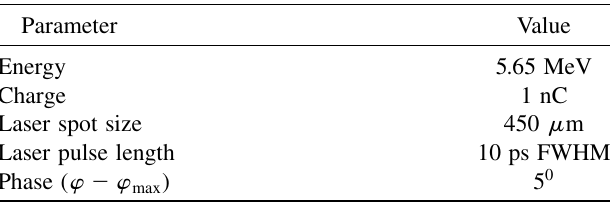
HIGH BRIGHTNESS ELECTRON BEAM EMITTANCE . . TABLE II. Parameters of the beam corresponding to the emit- tance measurement shown in Fig. 12.